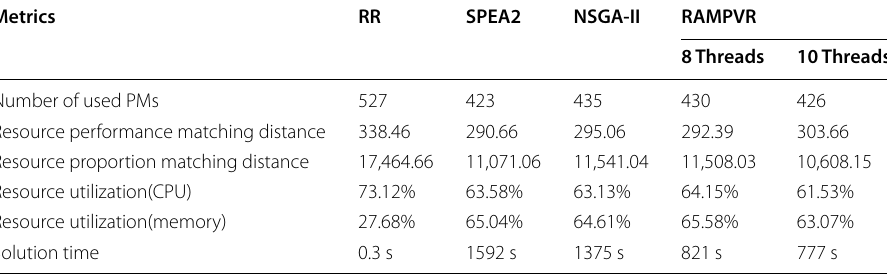
Number of used PMs 564 Resource performance matching distance 352.20 Resource proportion matching distance Resource utilization (CPU) 74.90% Resource utilization (memory) 28.76% Solution time